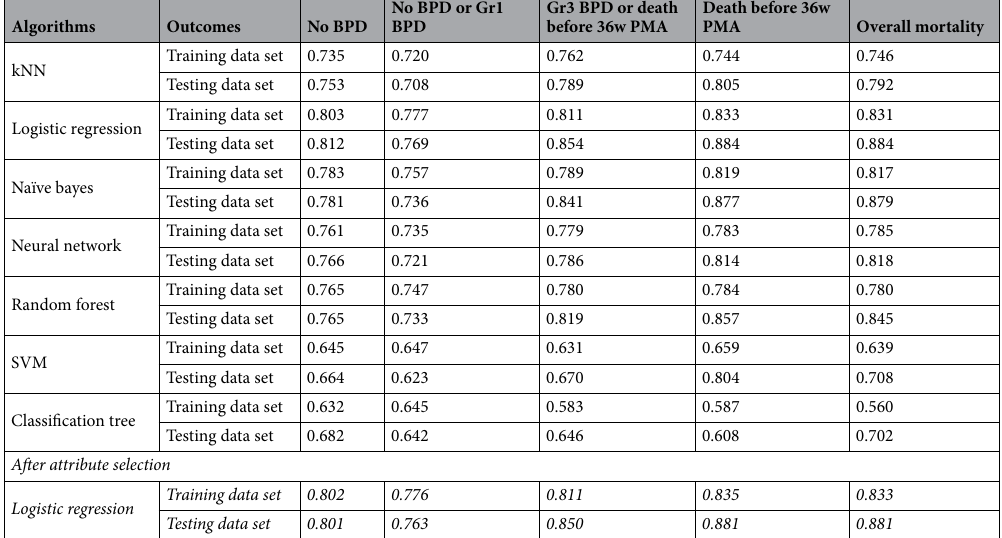
Attribute selection and simplified models. Among all 24 attributes, 5–7 attributes were selected for various target outcomes by using Weka, and the results were indicated in Table 4. Five attributes were selected for all target outcomes: BW, GA, intubation during initial neonatal resuscitation, early sepsis, and the adminis- tration of surfactant. Using these selected attributes, we used Orange and logistic regression algorithm to construct simplified prediction models. The AUROC values for predicting the various outcomes after attribute selection are listed in Table 3 (Italic data). The differences in AUROC values between the training and testing data sets were still small. Compared with the previous complex models, the simplified models had similar AUROC values. The AUROC values in the testing data set of the simplified models were 0.801 when predicting no BPD, 0.763 when